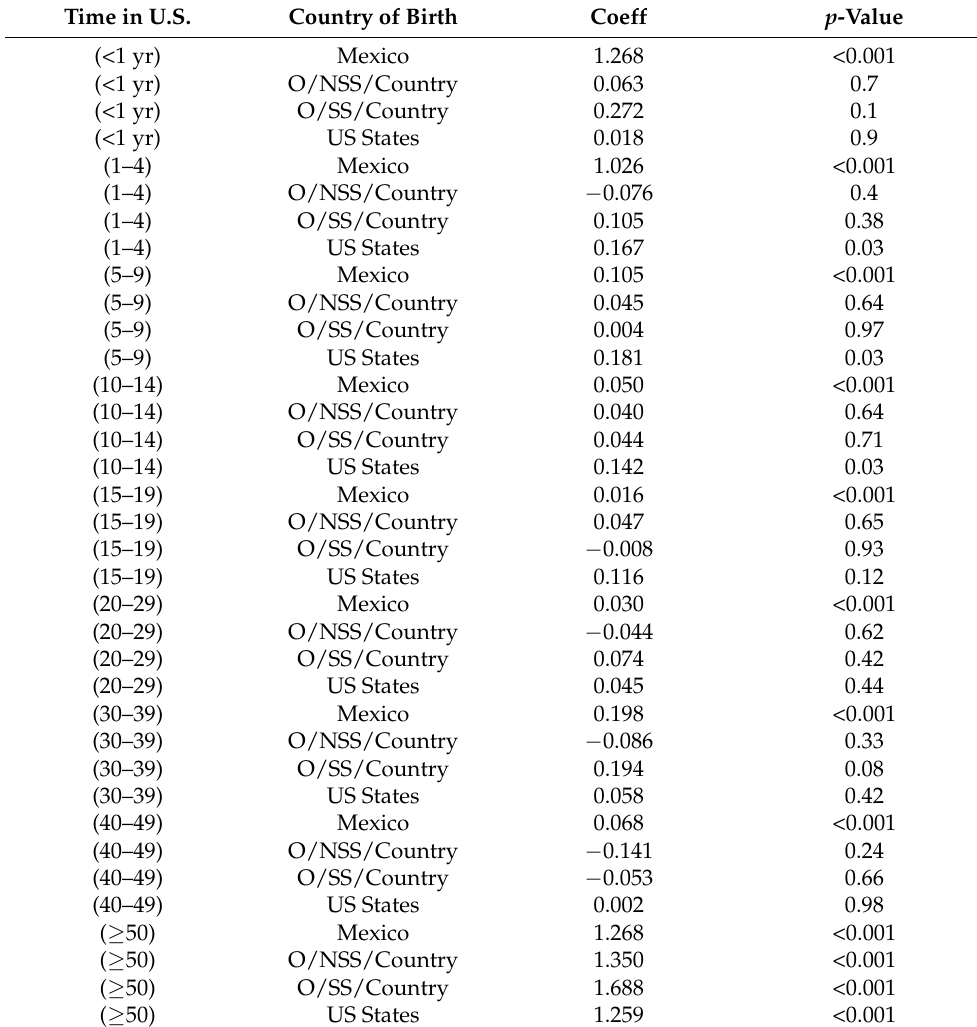
Table 2. Poisson modes for selected variables with AL. Time in